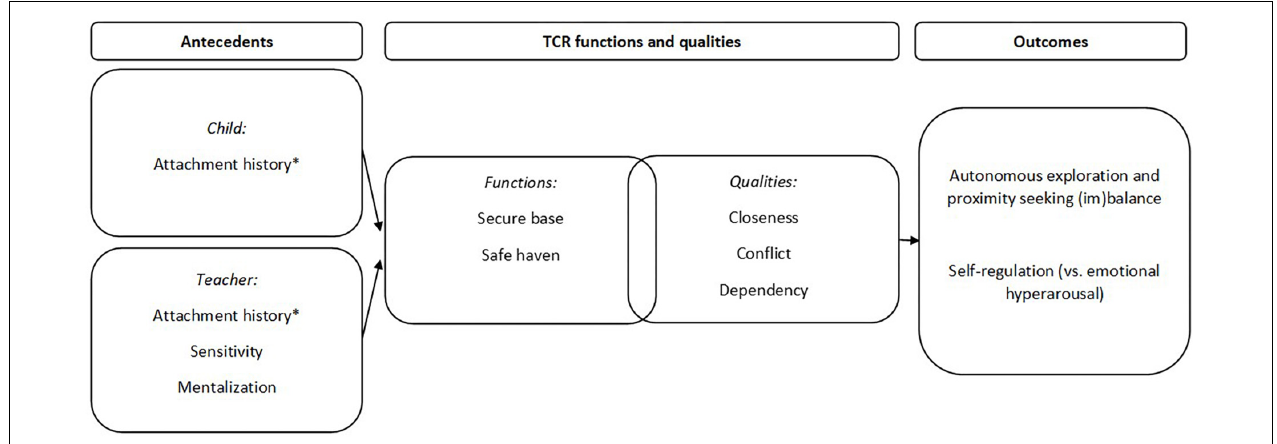
FIGURE 1 | Proposed model for the study of teacher-child relationships (TCR) from an attachment perspective. *Shaping more abstract and generalized internal working models (IWMs) of the self and